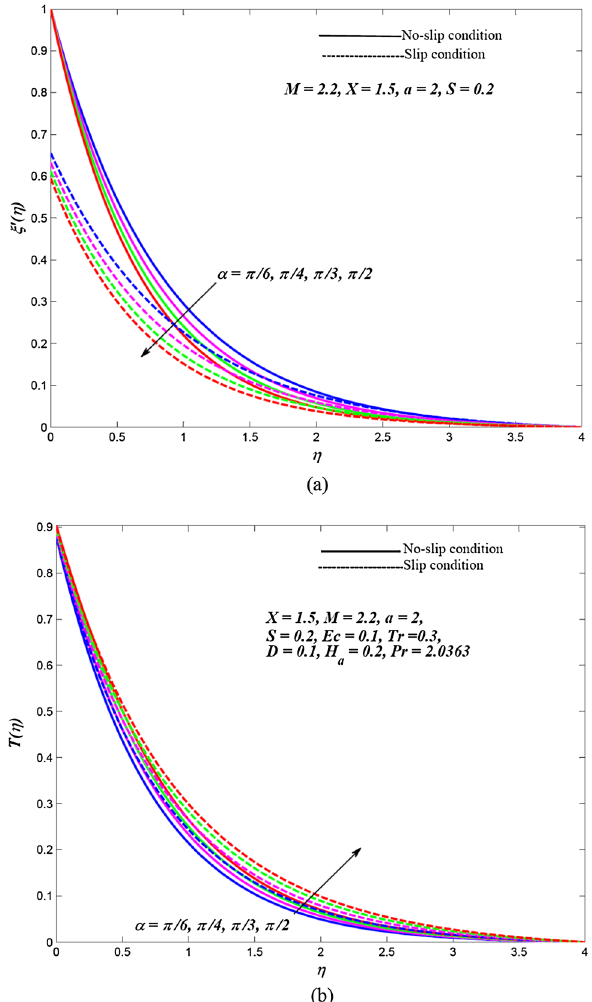
Figure 3. Effects of α on the dispersal profiles of hybrid ( a ) velocity ξ ′ (η) and ( b ) temperature T (η)